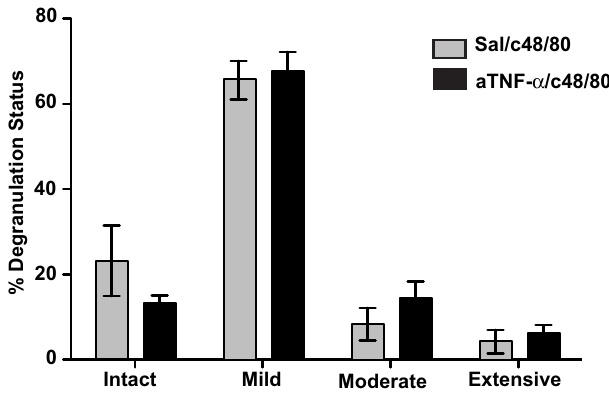
Figure 2. Pre-treatment with anti-TNF- α does not affect c48/80- provoked mast cell degranulation. Mice were pre-treated with 200μg/kg anti-TNF- α neutralizing antibody or vehicle (200μl, i.v. ) 30 minutes before bilateral intra-plantar c48/80 injection (1.5μg/ paw; 10μl). Mice were euthanized 2.5h after c48/80 administration; their hind paws were harvested, preserved in 10% buffered formalin and ethanol, and 4μm paraffin sections stained with toluidine blue for mast cell visualization. Mast cells were counted at 400x and their degranulation status was assessed as described previously 2 . Bars represent mean percentages of mast cells examined that are assigned to intact or mild, moderate and extensive degranulation status respectively and the error bars represent ±SEM. n = 3 mice per treatment group; data are representative of 2 experiments.